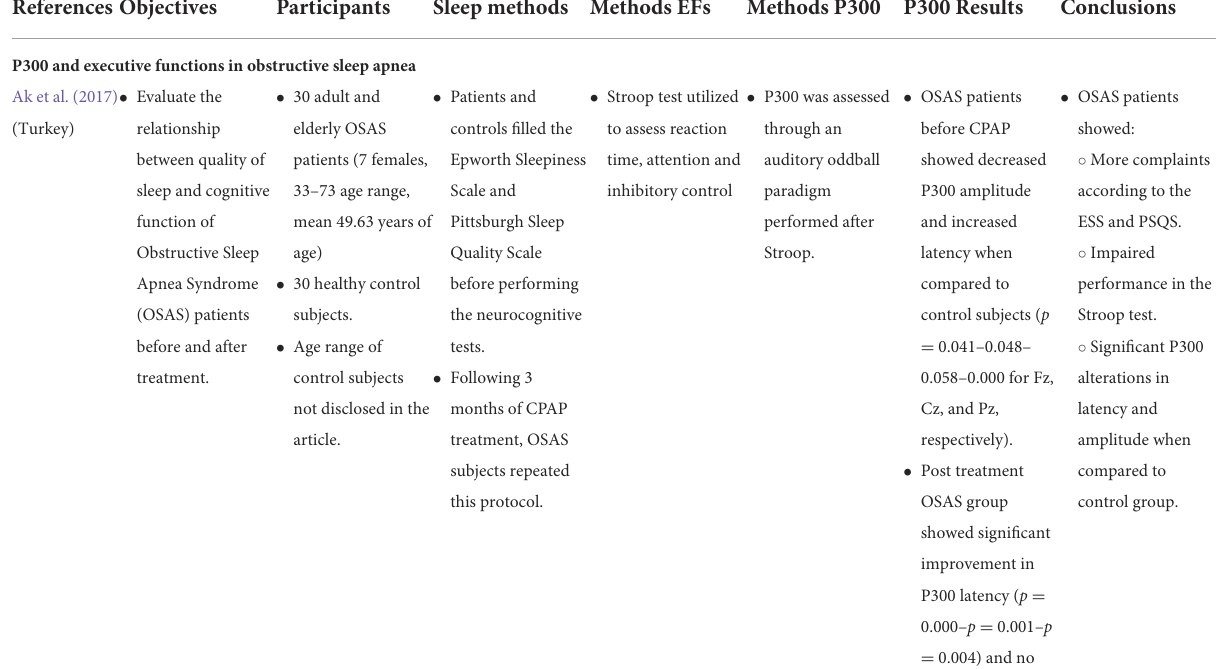
TABLE 1 Details of selected articles, according to following categories: authors and country of origin, objectives of the study, participants, study design, use of P300, and